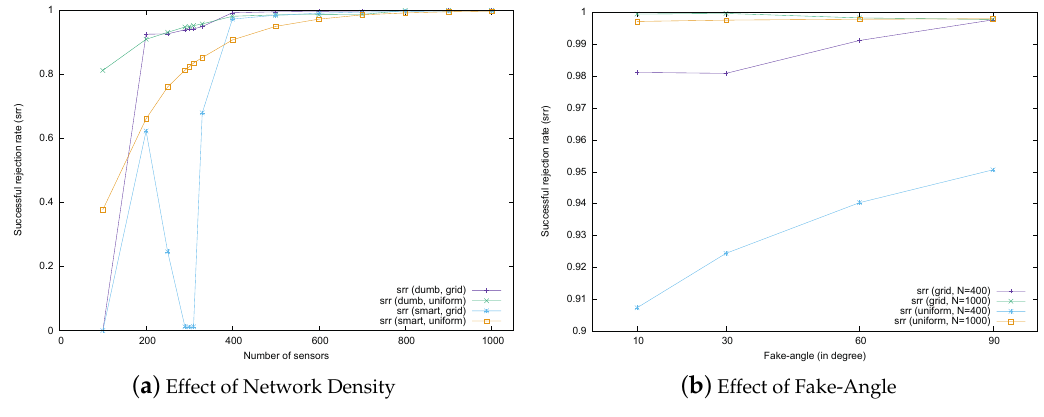
Figure 14. Successful rejection